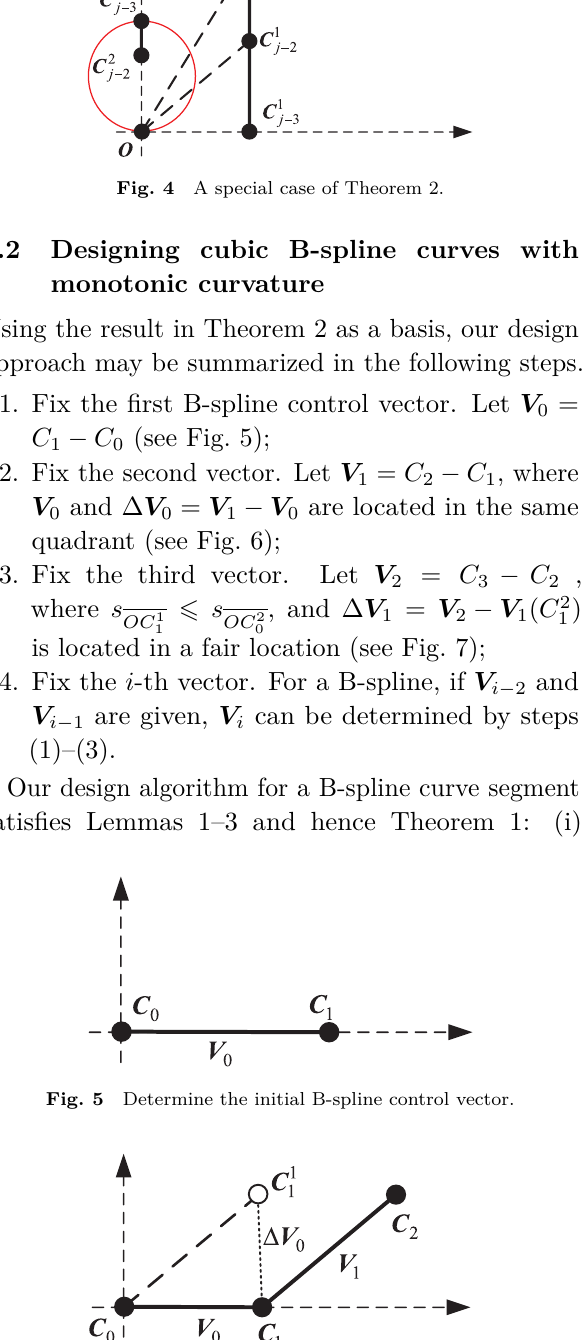
Fig. 3 Fair location. C 2 j − 2 is in a fair location if it lies within the red dashed region, which is bounded by OC 2 j − 3 , OC 1 j − 2 , and the red circle with diameter OC 2 j − 3 .